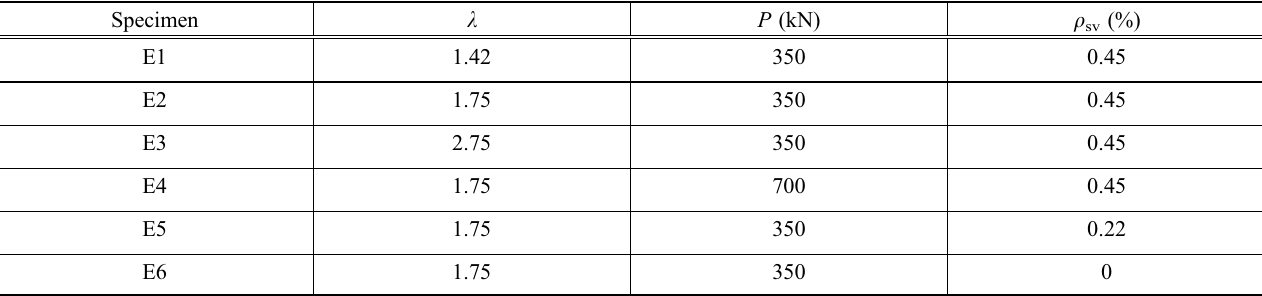
Table 4 Summary of specimen information.